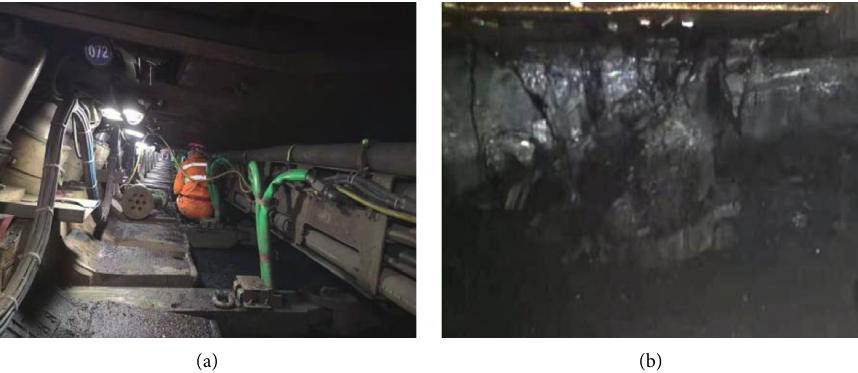
Figure 3: Support crushing and coal wall collapse in the 22306 working face, Shigetai mine.